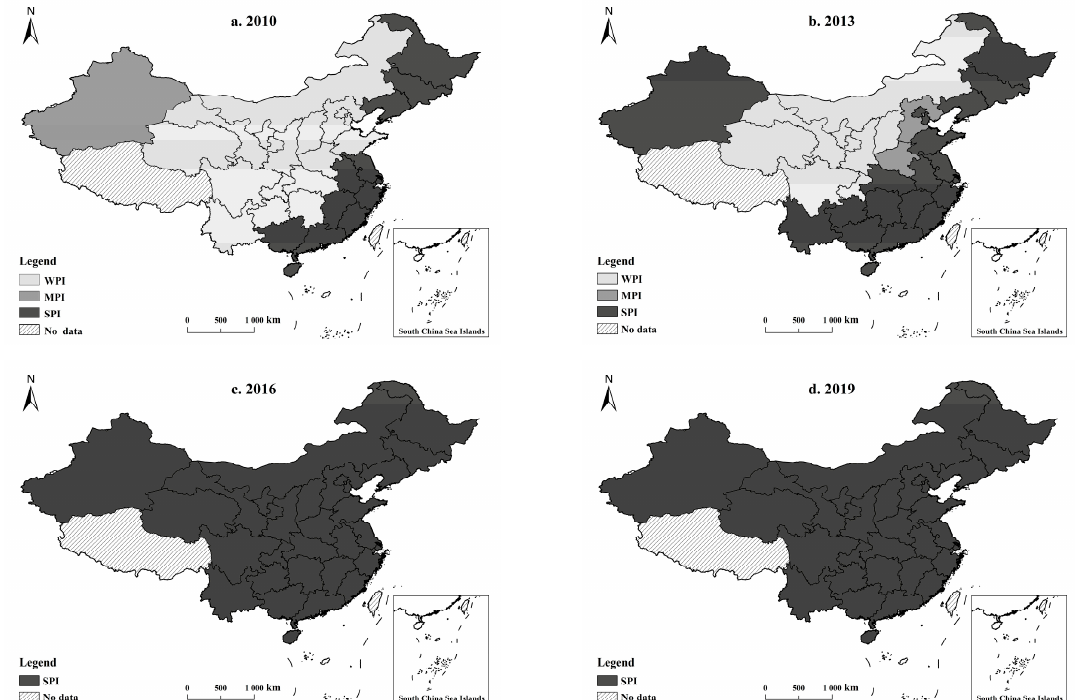
Figure 3. Spatial distribution of the regression coefficients of population: ( a ) Spatial distribution of the regression coefficients of the population in 2010; ( b ) Spatial distribution of the regression coefficients of the population in 2013; ( c ) Spatial distribution of the regression coefficients of the population in 2016; ( d ) Spatial distribution of the regression coefficients of the population in 2019.